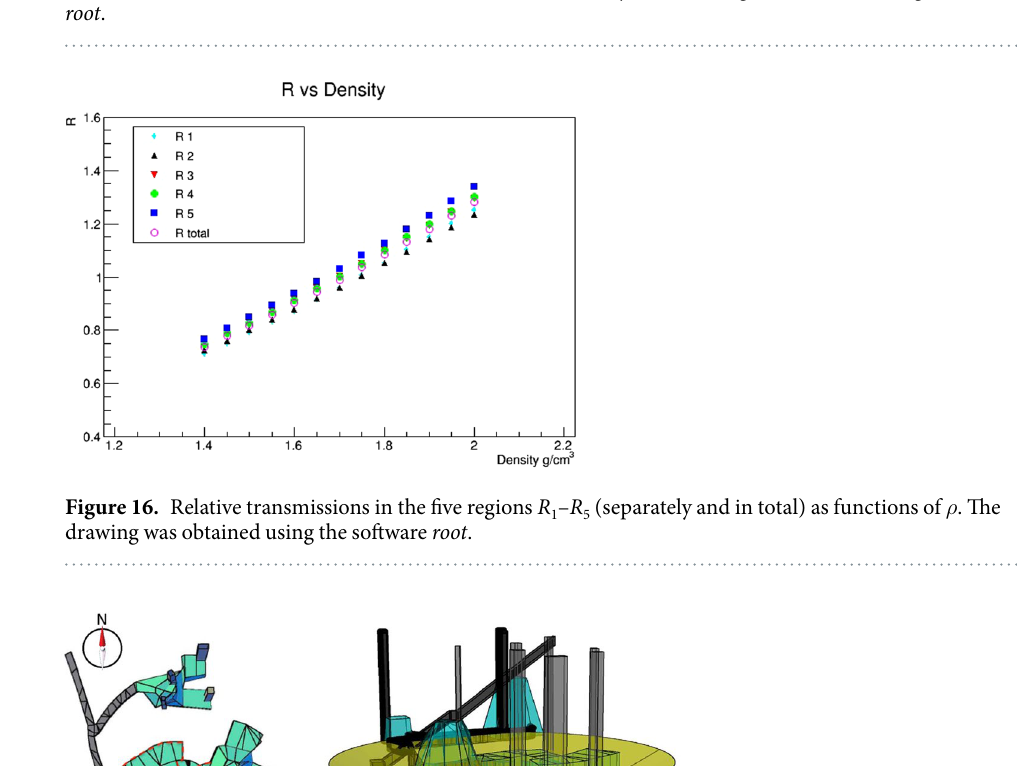
Figure 15. The relative transmission R( ρ α φ , , ) evaluated with ρ = 1.4 g/cm 3 . Regions with values higher than 2.5 have been saturated at this value. Also shown are five regions, where minimal relative transmission values have been selected to evaluate the best estimation of the density. The drawing was obtained using the software root .